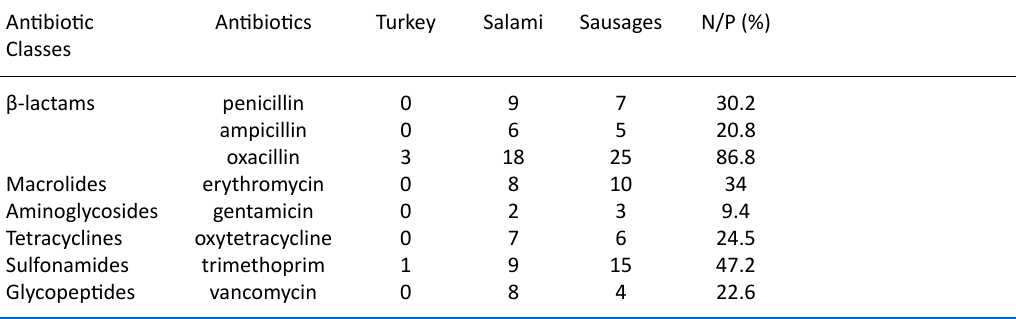
Fig. 1. Antibiotics susceptibility test among food samples collected from Riyadh, Saudi Arabia